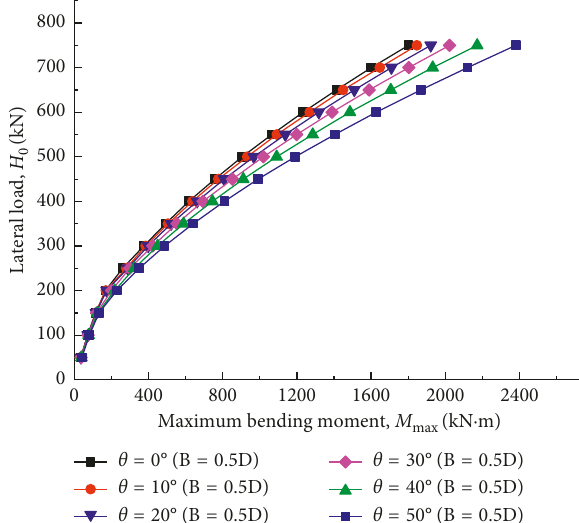
Figure 9: Lateral load-deflection curves for different slope angle at pile head.